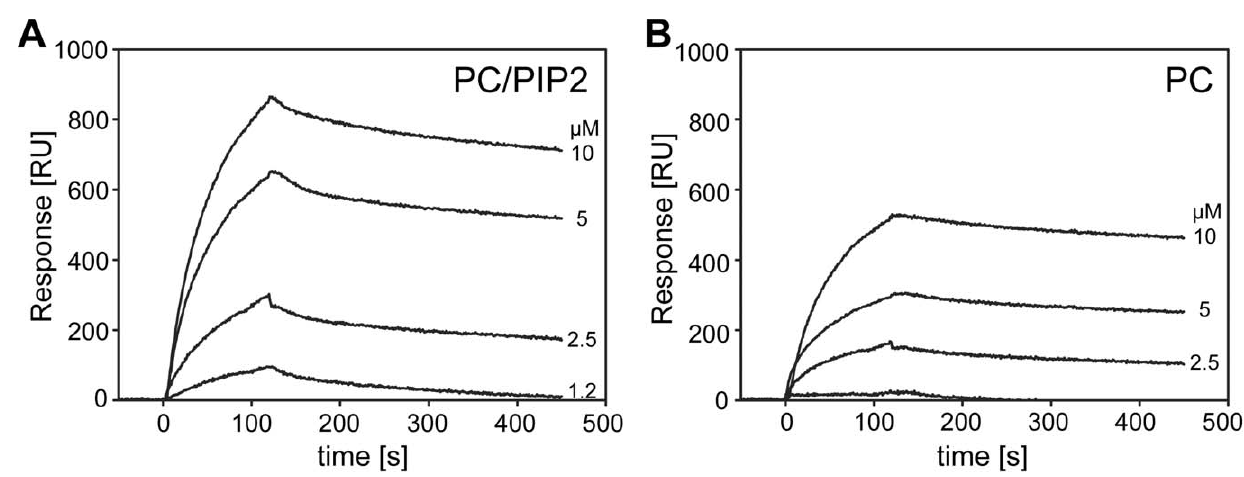
Figure 3. SPR kinetic binding of TRPV1-CT to PIP2-enriched liposomes (A) and to liposomes made from phosphatidyl choline (PC) (B). Both PIP2-enriched (PIP2/PC 80:20) and PC liposomes were immobilized to the sensor chip at the same density ( , 1000 RU), and the TRPV1-CT protein at indicated concentrations was injected in parallel over the lipid vesicles at flow rate of 30 m l/min.